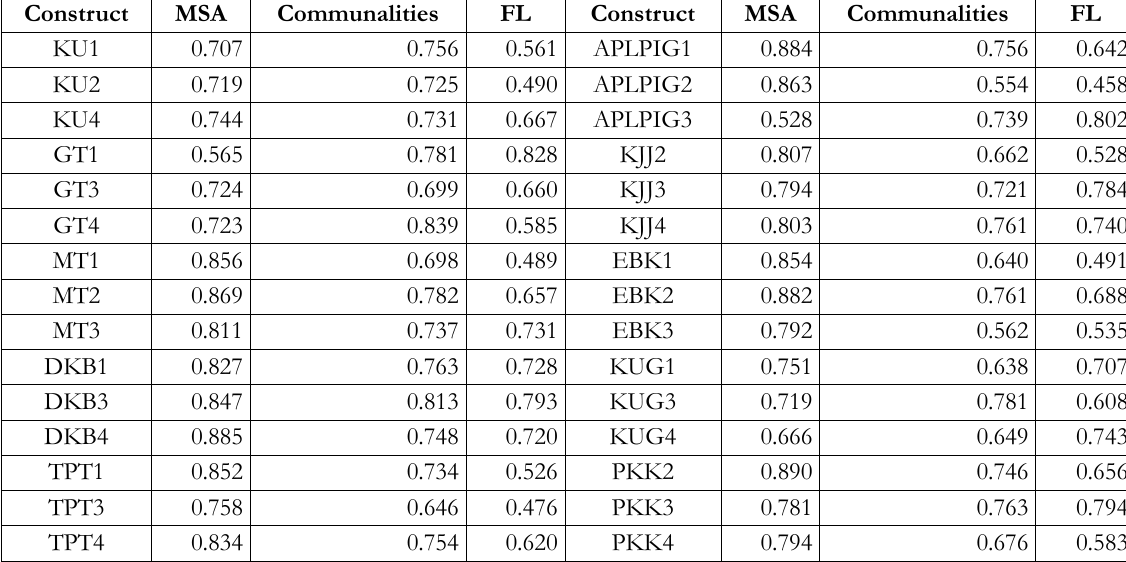
Table 4. The output of the EFA analysis